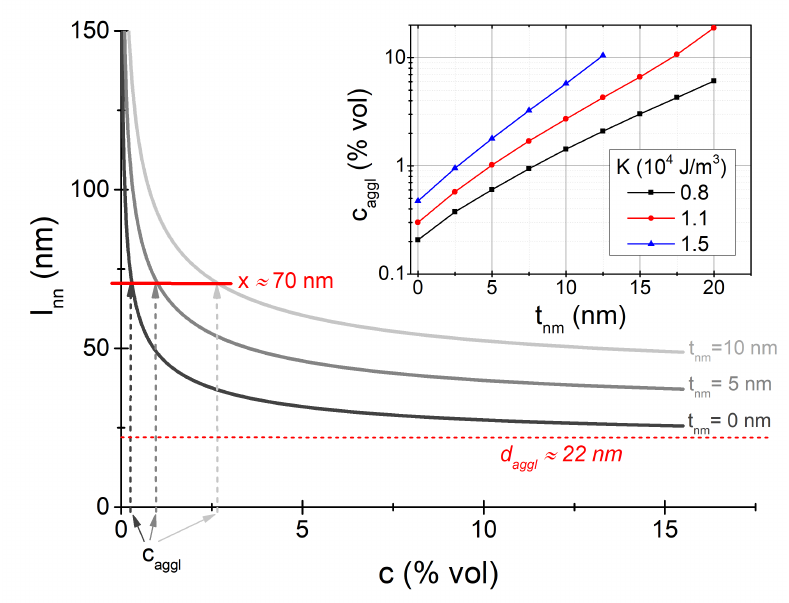
Figure 6. l NN vs. c curves for different t nm values, for the K = 1.1 × 10 4 J/m 3 case. The short (solid) horizontal line indicates the interparticle distance predicted by Equation (5), whereas the long (short-dashed) one indicates the d aggl value, to which l NN tends asymptotically. The vertical arrows indicate the corresponding c aggl values. The inset shows c aggl vs. t nm for the different values of K